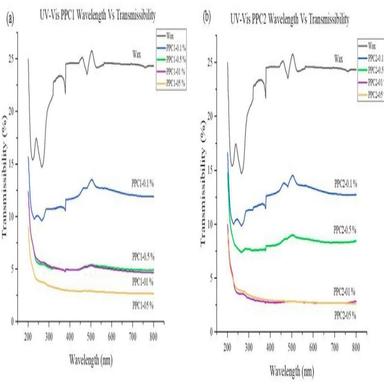
UVeVis results for a) PPC1 Wavelength vs Transmissibility; b) PPC2 Wavelength vs Transmissibility.